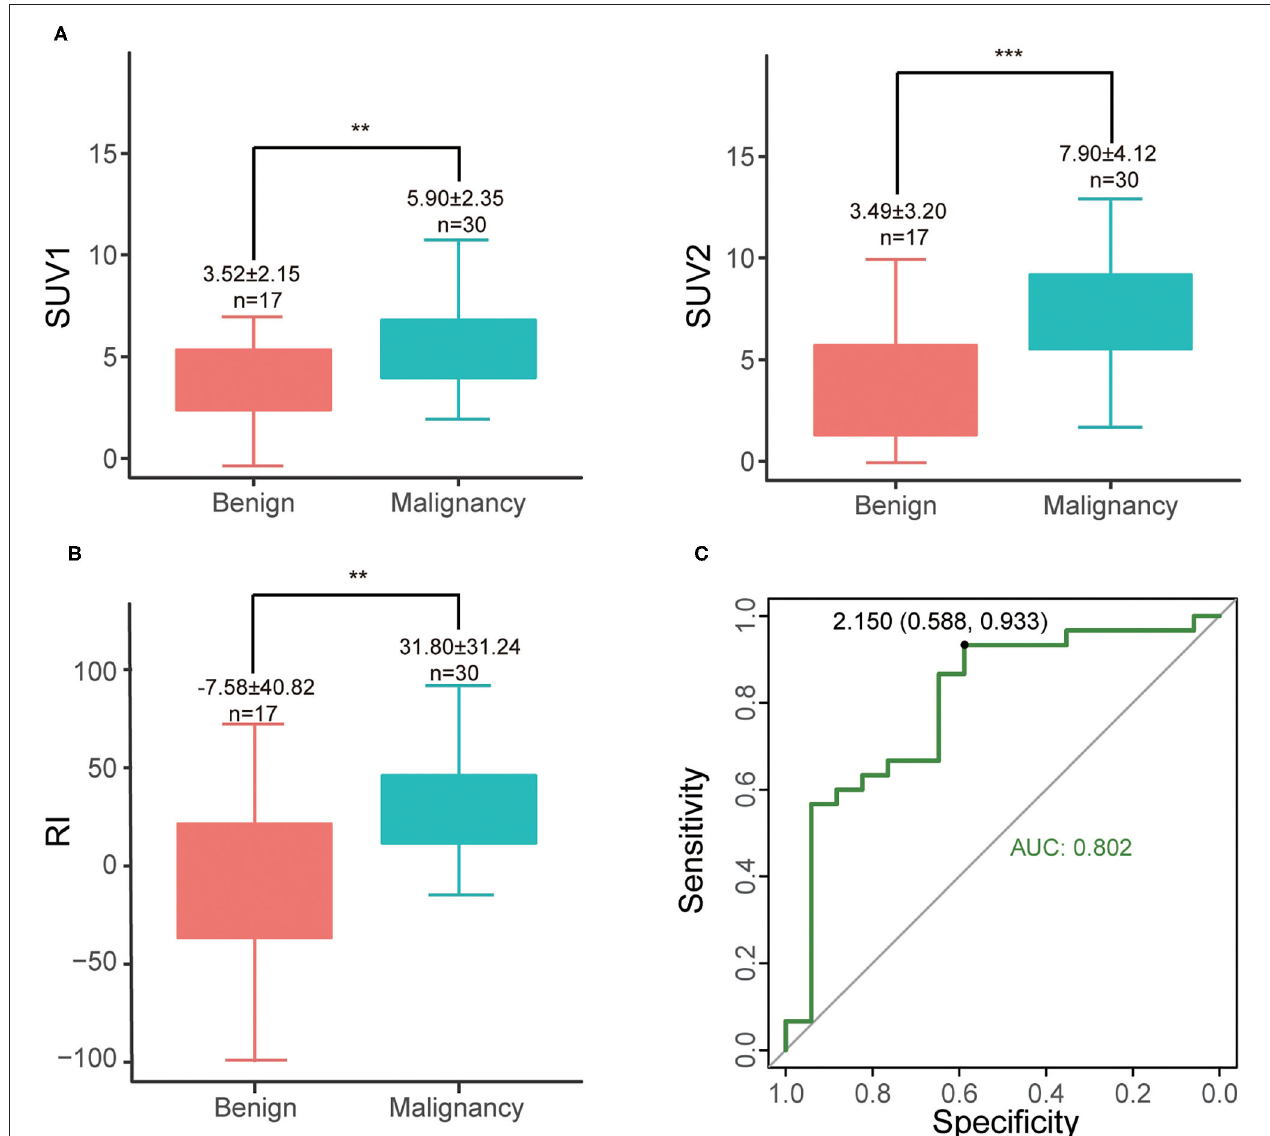
FIGURE 3 | (A) Differences of SUV1 and SUV2 between malignant and benign groups, ** P < 0.01; *** P < 0.001; (B) RI of different groups; (C) ROC curve of